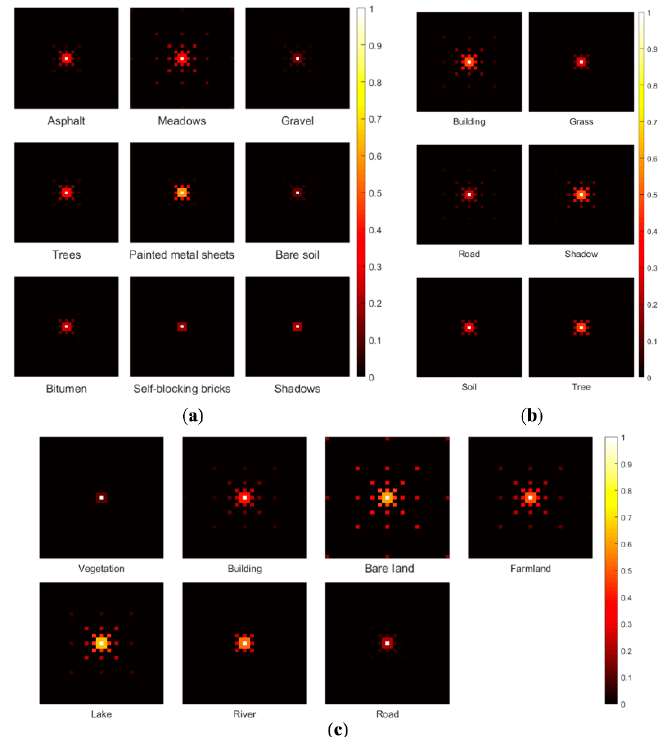
Figure 8. Spatial pattern in the form of MP probabilities derived from MLC classification results: ( a ) The ROSIS image, ( b ) the IKONOS image, and ( c ) the Landsat image.